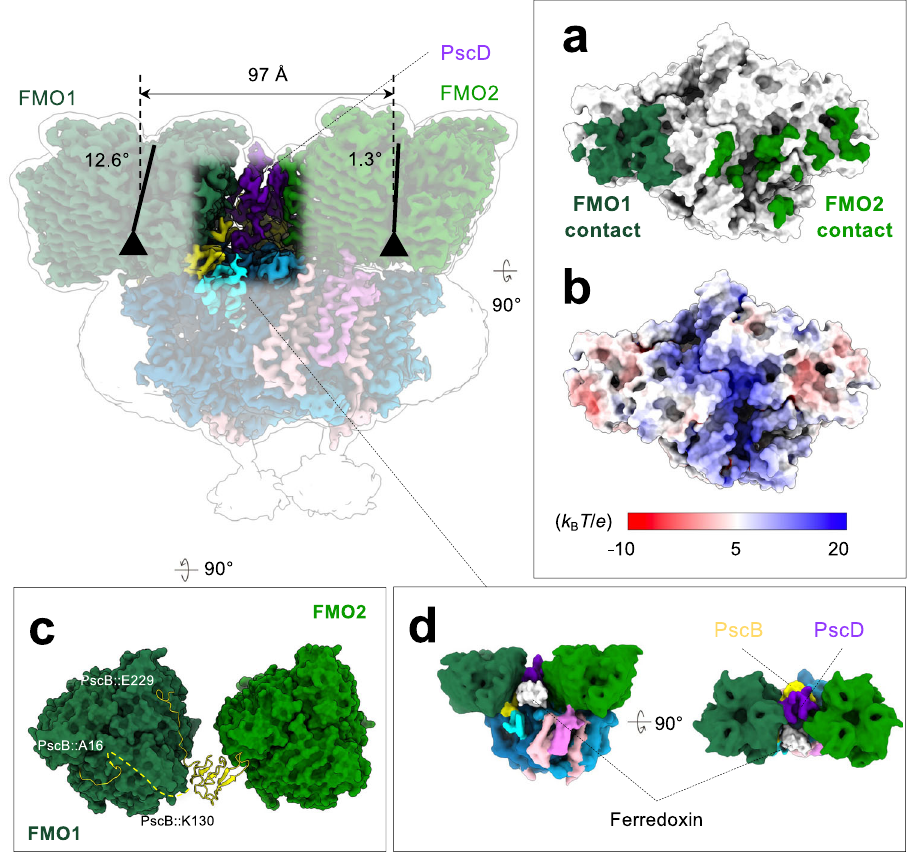
b ElectrostaticpotentialmapoftheRCcytoplasmicsurface.Valuesarepresentedas the energy perunit charge ( k B T/e ).Colorbarindicates blue andred aspositive and negative values, respectively. c PscB (yellow) has a larger contact with the FMO1 (dark green) than FMO2 (forest green). Yellow dashed curve represents the unmodelled loop from residue 17 – 129 of PscB. d Schematics of the potential fer- redoxin docking site. White surface represents the ferredoxin enzyme (UniProt accession number: